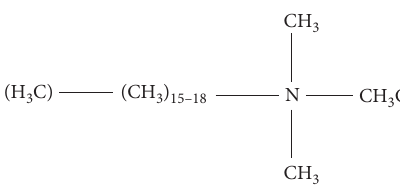
Figure 11: Quaternary ammonium salt.